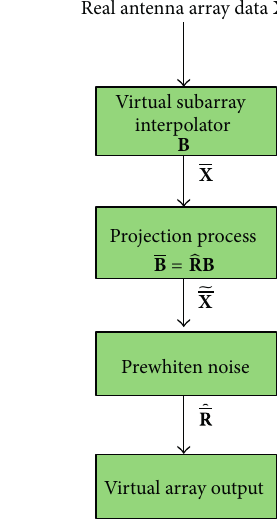
Figure 3: Construction of modified interpolated